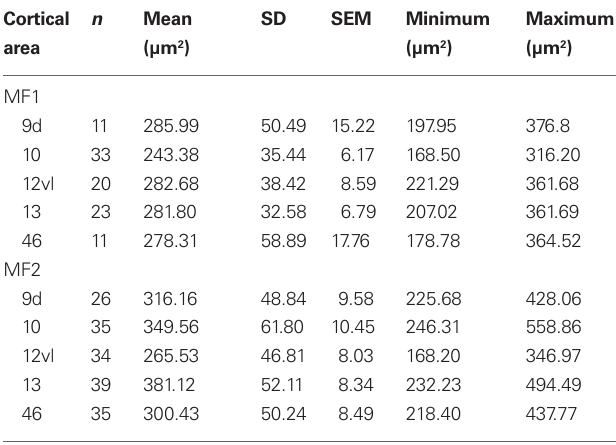
Table 5 | Number, size [mean, standard deviation (SD), standard error of the mean (SeM), minimum, and maximum] of the basal dendritic trees of layer iii pyramidal cells in cortical areas 10, 13, 9 (medial and dorsal), and 32 in the vervet monkey.